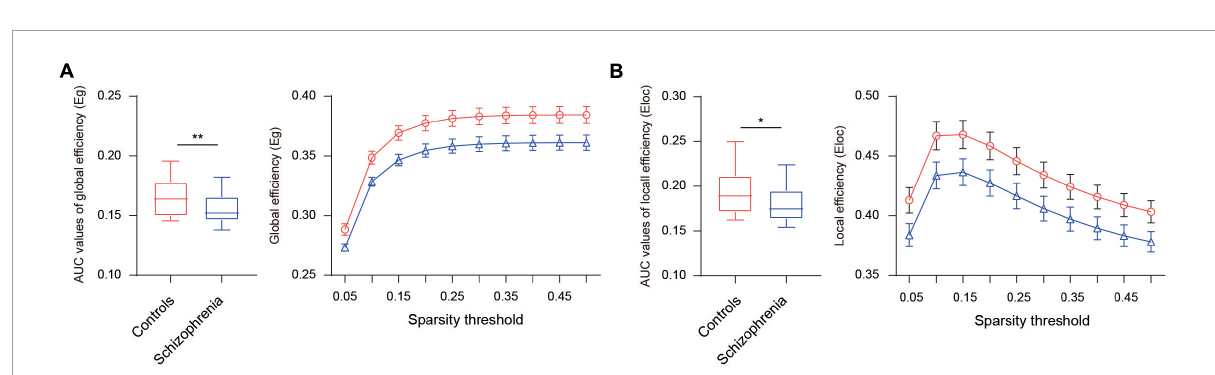
FIGURE2 Differences in the integration and segregation of whole-brain network for the schizophrenia group and healthy control group. (A) The left panel displays AUC values of global efficiency, the right displays global efficiency in different sparsity thresholds (5–50% in 5% increments). (B) The left panel displays AUC values of local efficiency, the right displays local efficiency in different sparsity thresholds (5–50% in 5% increments). *Indicates p ≤ 0.05, **indicates p < 0.01.